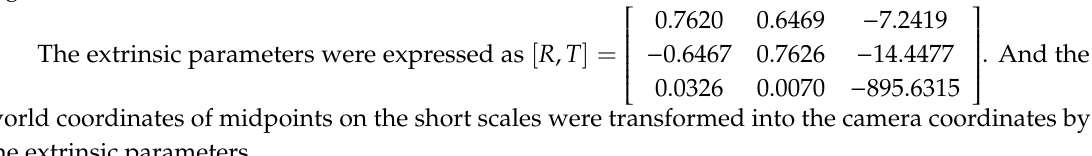
602= .5 r mm and 584= .6 r mm respectively. l s